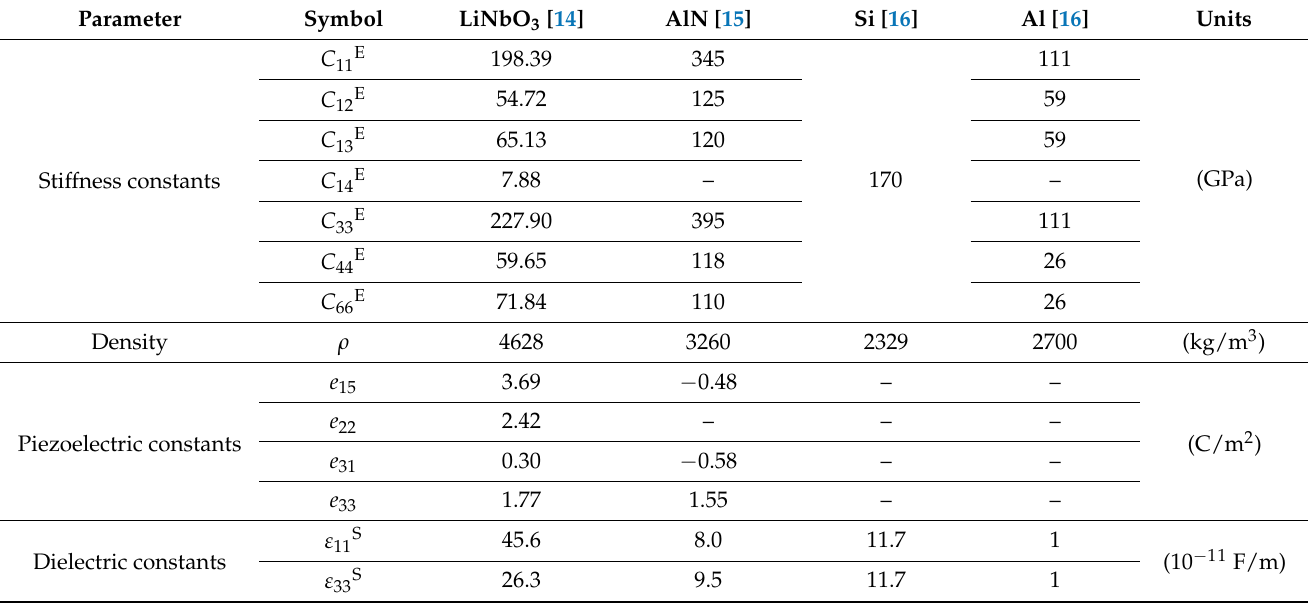
Figure 1. Comparison of simulated displacement amplitudes of ( a ) LiNbO 3 substrate, ( b ) LiNbO 3 /Si, and ( c ) AlN/ LiNbO 3 /Si for the SH wave. The insets are the mode shapes at antiresonances simulated with periodic structures using FEM simulation ( h LiNbO3 / λ = 0.25, h AlN / λ = 0.2, h IDT,Al / λ = 0.08 are used in the plots). Table 2. LiNbO 3 , AlN, Si, and Al material constants used in the simulations [14–16].